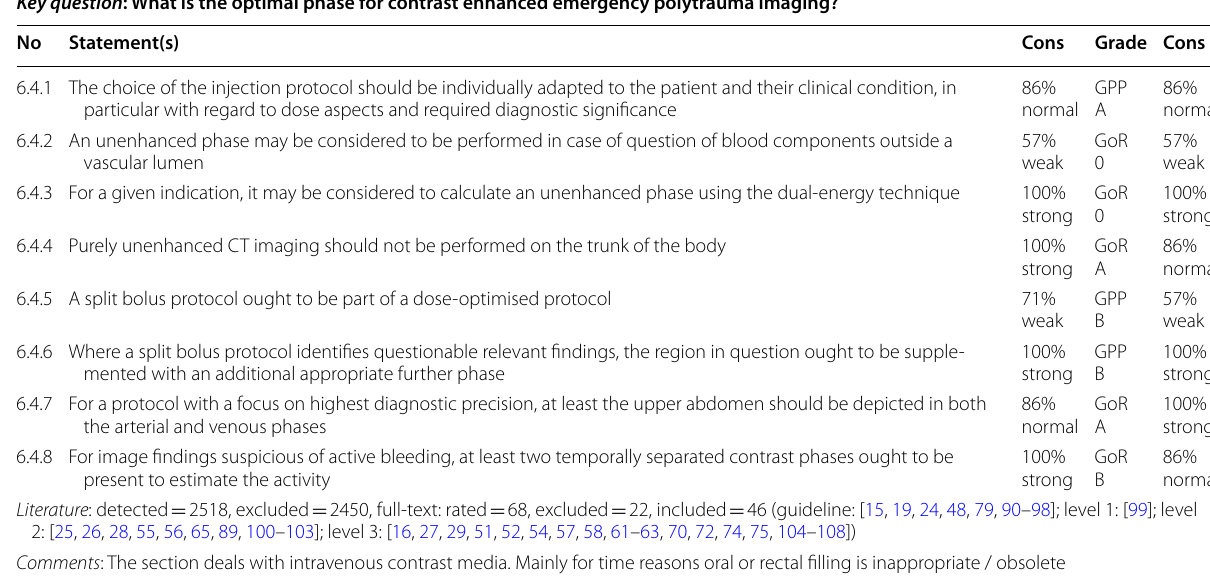
Table 13 Section 6: Whole Body CT – Protocol, key issue 4: contrast phase Key question : What is the optimal phase for contrast enhanced emergency polytrauma imaging?